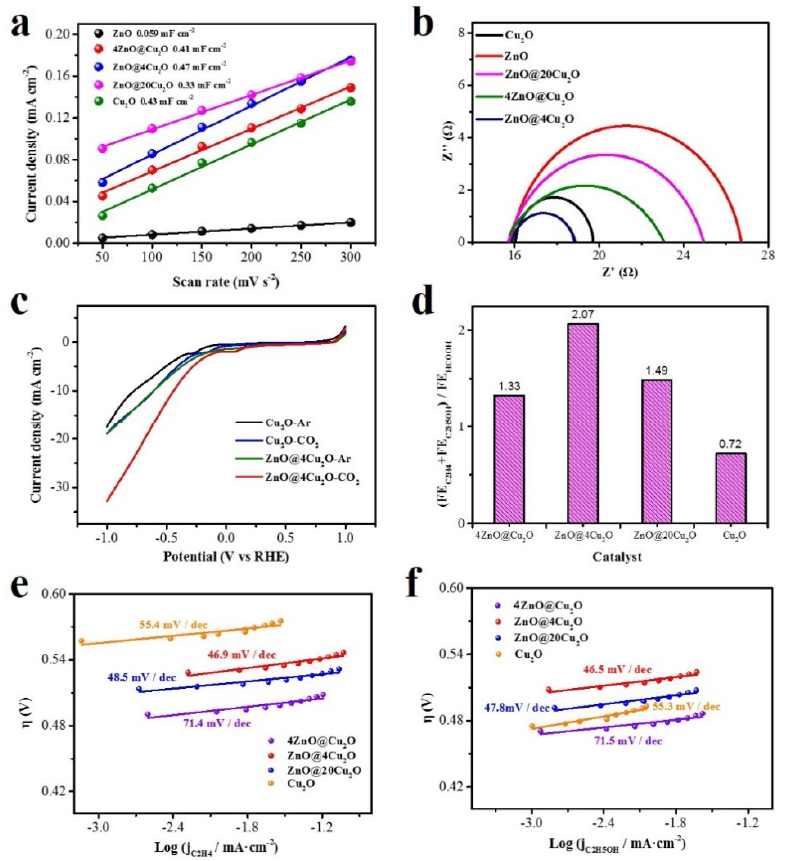
Figure 8. Electrochemical characterizations of different catalysts. ( a ) Double-layer capacitance measured by cyclic voltammetry in 0.1 M KHCO 3 saturated by CO 2 . ( b ) Electrochemical impedance spectroscopy (EIS) plots were carried at − 1.0 V vs. RHE in 0.1 M KHCO 3 saturated with CO 2 . ( c ) Linear sweep voltammetry (LSV) curves measured in 0.1 M KHCO 3 solution saturated by CO 2 and Ar with a scan rate of 10 mV s − 1 . ( d ) The ratio of Faraday efficiency of C 2 H 4 and C 2 H 5 OH to Faraday efficiency of HCOOH on catalysts with different shell thickness. Tafel Kinetics over